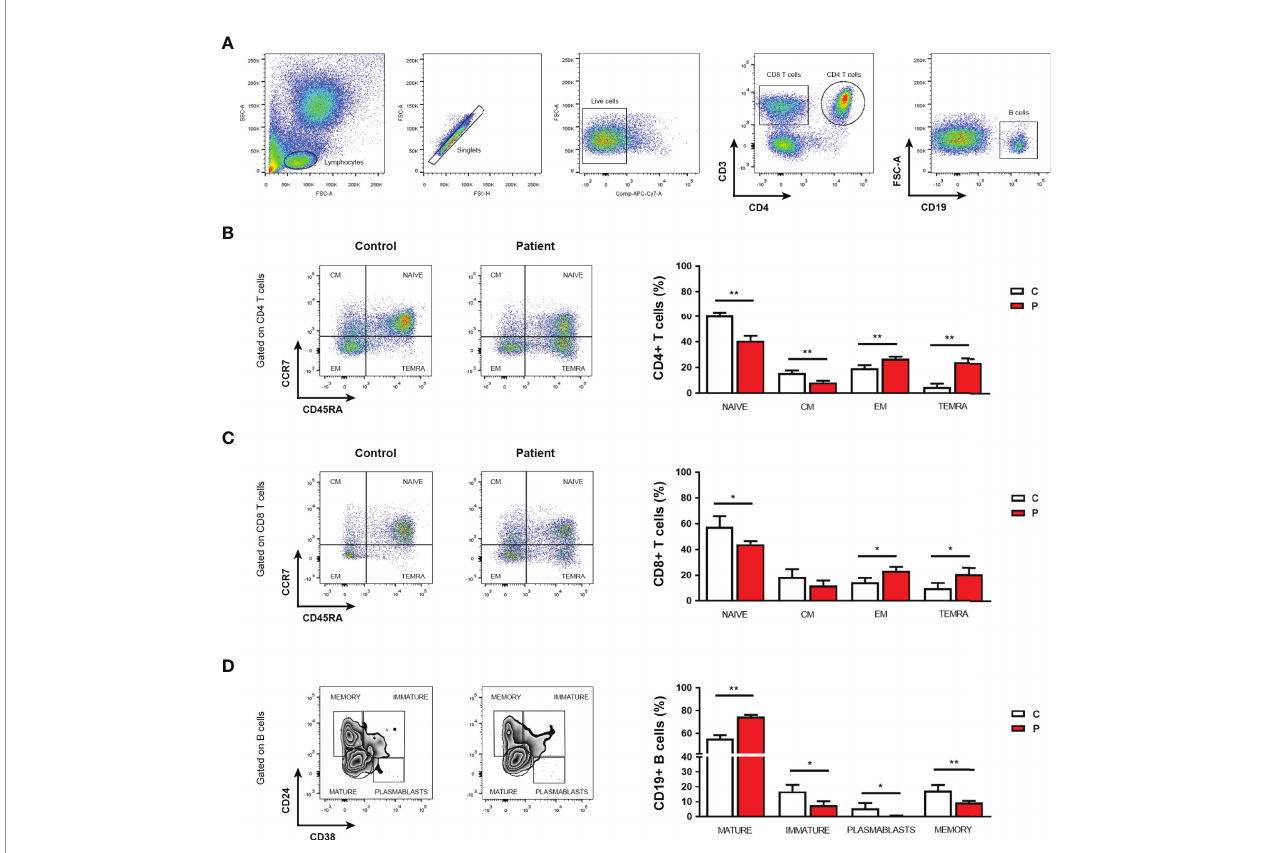
FIGURE 3 | Phenotypic analysis of T and B cells . (A) Flow cytometry gating strategy for the assessment of phenotypic cell markers in live CD4 and CD8 T cells, and B cells from PBMC after red blood cell depletion by lysing buffer treatment. (B, C) Frequencies of naïve T cells, central memory (CM), effector memory (EM), and terminally differentiated effector memory cells (TEMRA) within the CD4+ (B) or CD8+ (C) T cell populations from the patient (P) under study and controls (C). (D) Frequencies of mature, immature and memory B cells, and plasmablasts in peripheral blood from the patient (P) under study and controls (C). Representative fl ow cytometry dot plots. Experiments were performed in triplicates. Data are shown as mean ± SEM, the patient and sex and age-matched control individuals (n=6 healthy females, aged 3-7 years old). Red bars correspond to the average values of the patient and white bars correspond to the average values of the controls analyzed. Mann-Whitney test; * p < 0.05 and ** p < 0.01. The following fl uorescent-labeled anti-human antibodies (BioLegend) were used: CD3 (PerCP), CD4 (APC), CD19 (APC), CD45RA (PE-Cy7), CCR7 (PE), CD24 (FITC) and CD38 (PE). Dead cells were excluded using LIVE-DEAD ™ fi xable (Invitrogen). Data were collected on FACS-CANTO II fl ow cytometer (BD Biosciences) and analyzed using FlowJo software (version 7.6.2). Proper compensation using Fluorescence Minus One (FMO) controls were